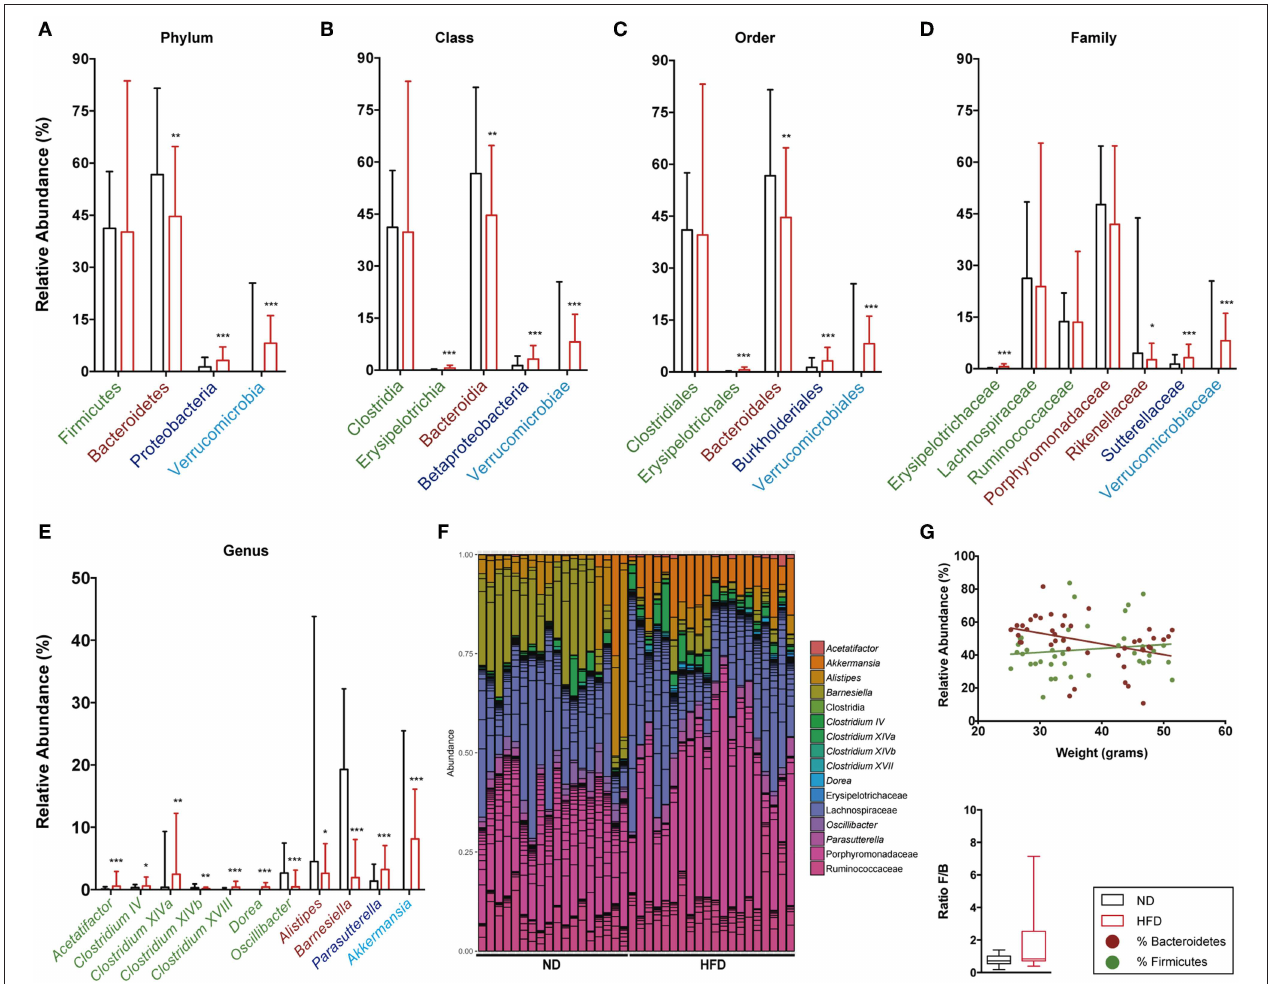
FIGURE 9 | Taxonomic composition of the intestinal microbiota based on 16S rRNA sequencing at week 16 after starting both diets. Analysis of the relative abundance of the most abundant phylum (A) , class (B) , order (C) , family (D) , and genus (E) in ND vs. HFD. (F) Bar plot representation of the OTUs of each sample according the taxonomic classification. (G) Regression plot of Firmicutes and Bacteroidetes phyla against animal weight and analysis of the F/B ratio in ND and HFD. * p < 0.05, ** p < 0.01, *** p < 0.001; Mann–Whitney